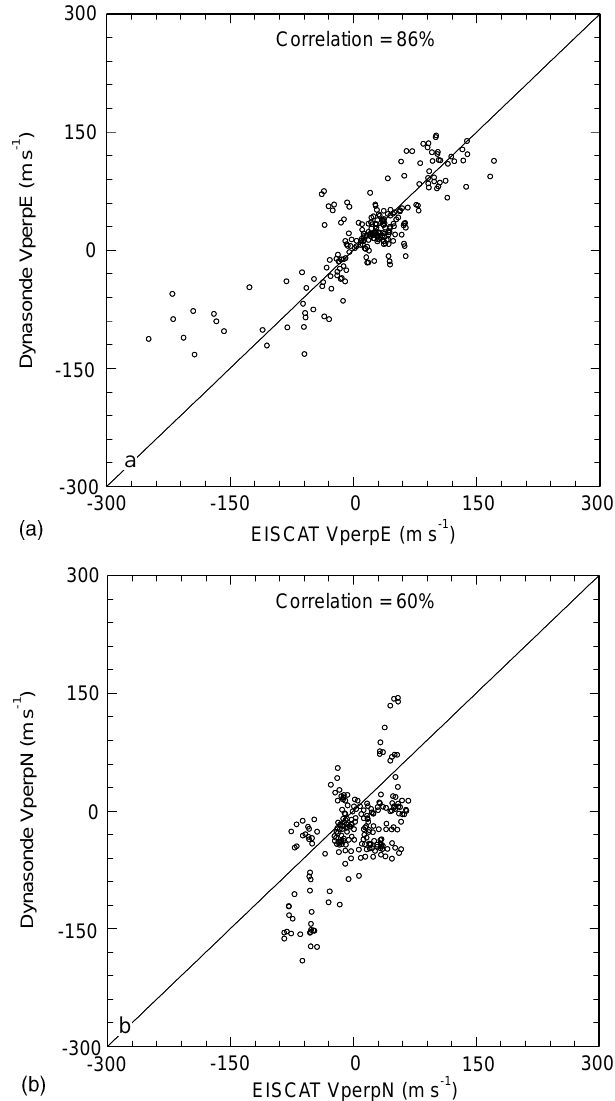
Fig. 7a,b. Correlation between EISCAT and Dynasonde velocities during the experiment CP-1-K, 8 — 9 June 1994. a East-west com- ponent, and b north-south component; all values are 54 min aver-